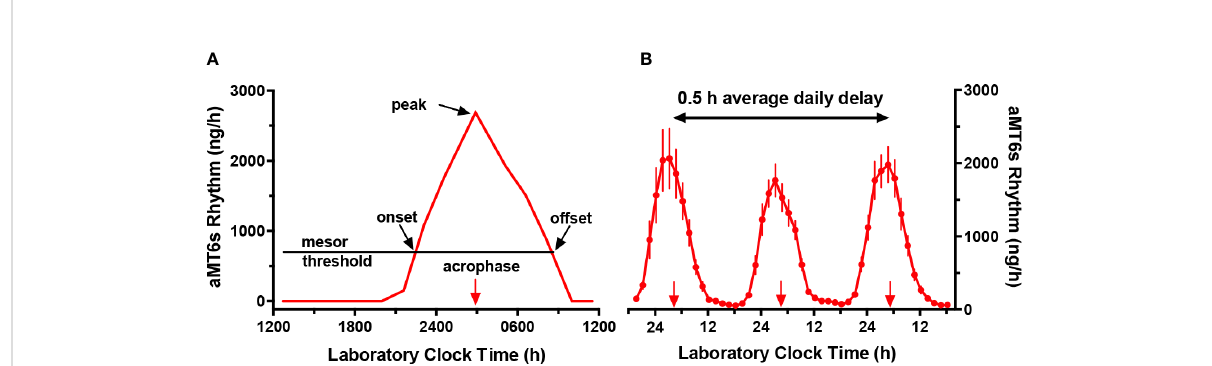
FIGURE 1 Circadian rhythms of urinary 6-sulfatoxymelatonin excretion (aMT6s, ng/h) in laboratory 2 h wake: 1 h sleep schedules repeated for > 24 h. (A) Schematic fi gure illustrating an individual baseline rhythm showing times of aMT6s onset (evening rise) and offset (morning decline), each measured, respectively, from upward and downward crossings of the cosine mesor (threshold). Also indicated are the cosine acrophase (time of mean vector of the cosine fi t) and the time of the nighttime peak (the single highest ng/h value in the 24 h pro fi le). (B) Robust aMT6s rhythm observed in young subjects studied in a 2 h wake: 1 h sleep schedule for 72 h. Under these conditions, in the absence of 24 h cycles in key environmental time cues, successive times of aMT6s onset and acrophase delayed on average 0.5 h per day from nights 1 to 3 (plotted points represent means ± 95% CI, n=17), demonstrating regulation by an internal endogenous circadian clock demonstrating regulation by an internal endogenous circadian clock. Normally, aMT6s and other circadian rhythms are synchronized to a period of 24 h by the 24 h cycles of our